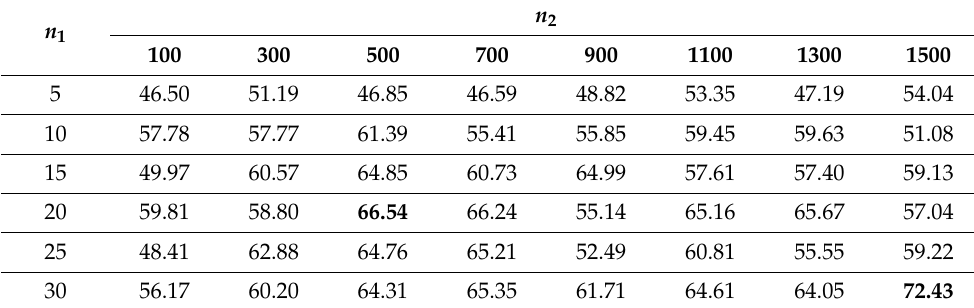
Table 2. The results of hyper-parameter experiments.